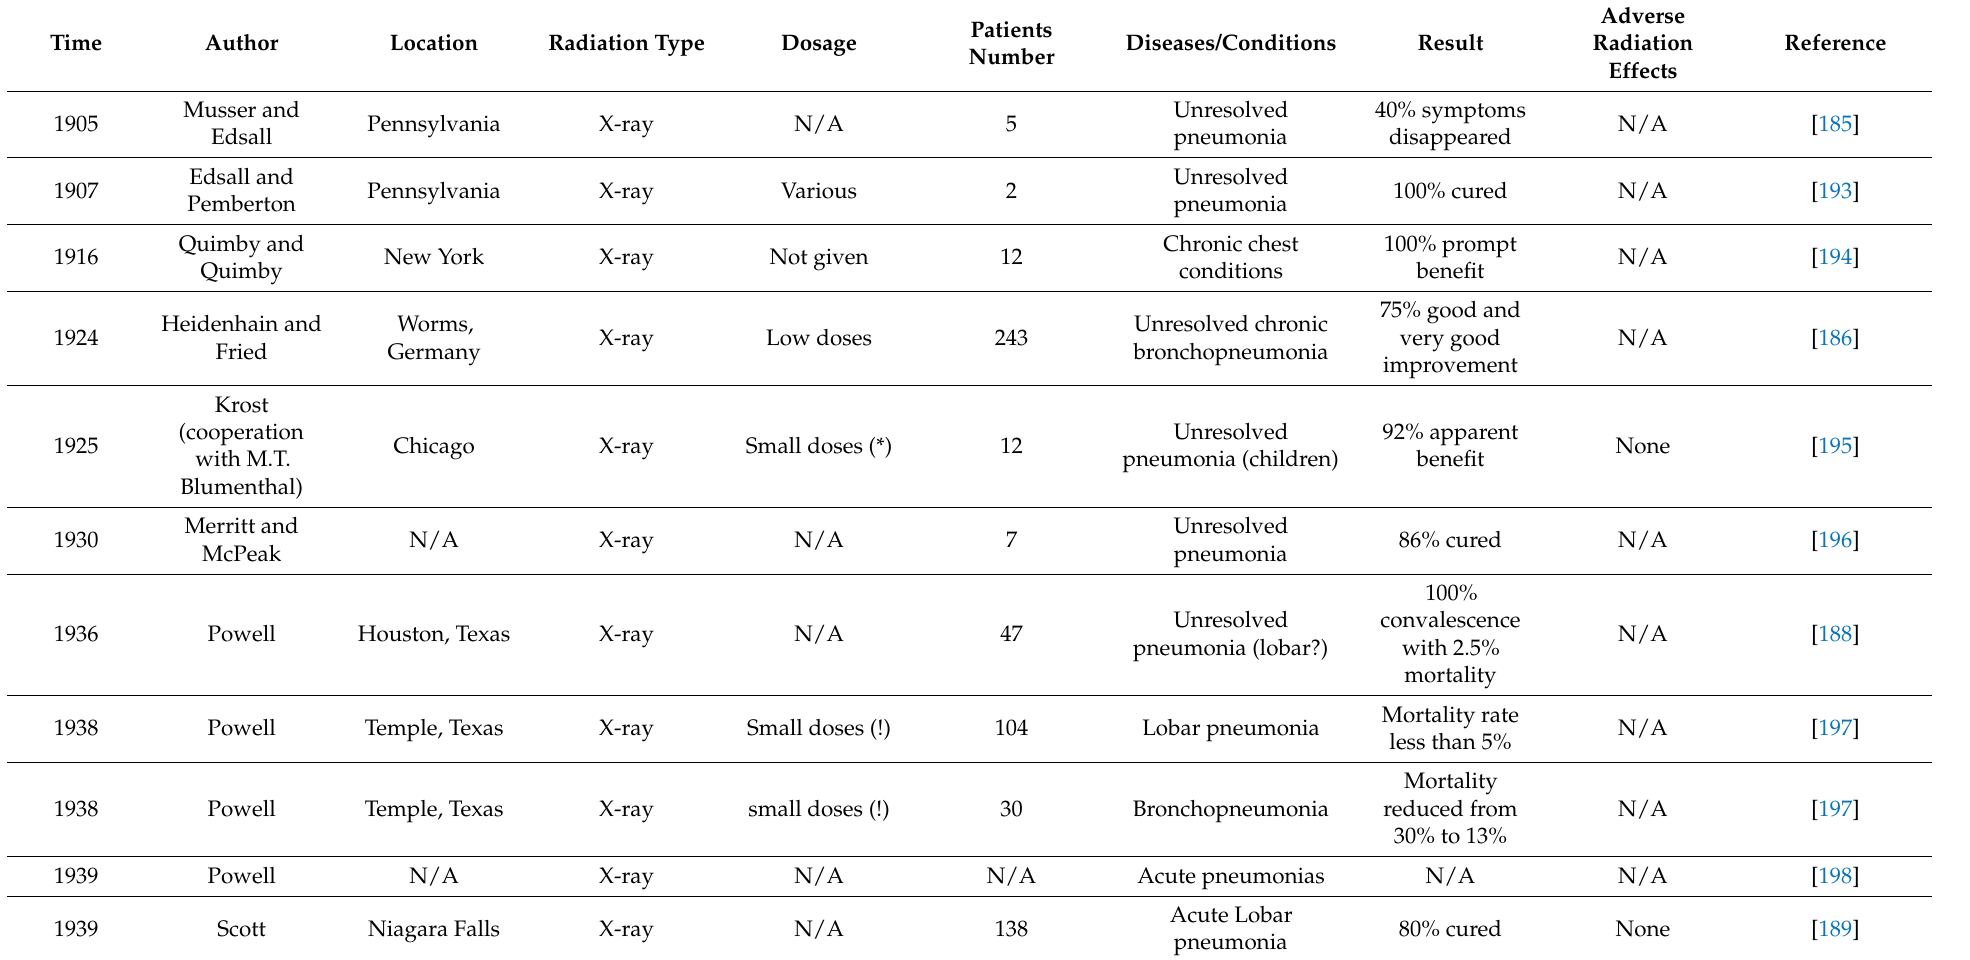
Table 1. Brief History of X-ray Therapy on non-COVID-19